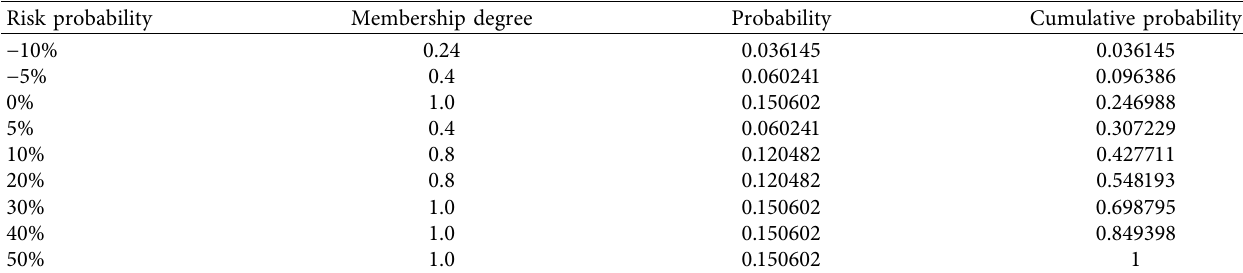
Table 3: Probability distribution of value